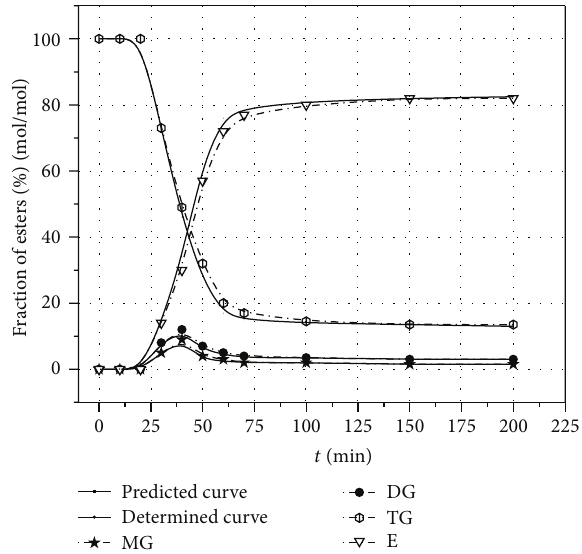
Figure 4: Effect of stirring rate on ester production.